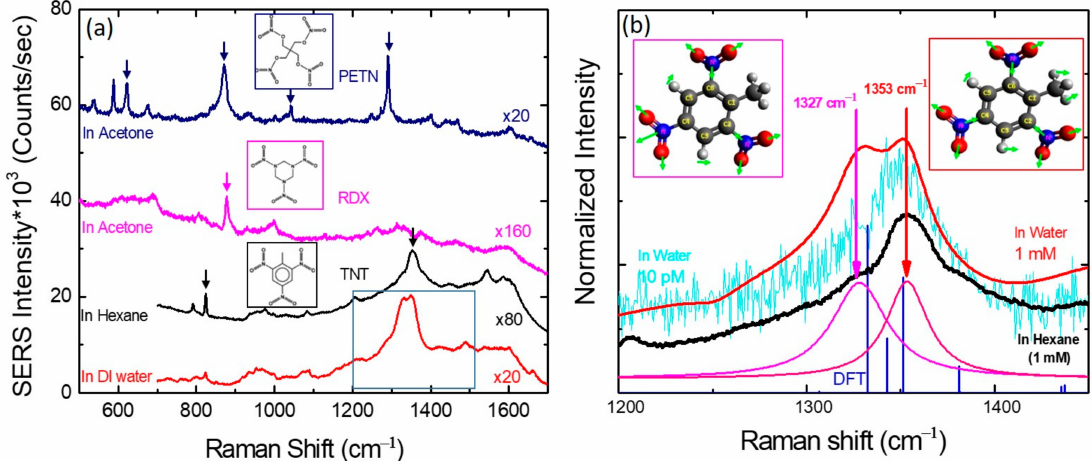
Figure 3. ( a ) SERS spectra from PETN, RDX, TNT/water, and TNT/hexane. The concentrations of all four samples are the same, 1 mM. The geometry of each molecule is given in the inset. ( b ) Symmetric NO 2 modes of TNT molecules in the SERS spectra compared with the DFT simulation results (blue). The vibrational directions (green arrows) of the atoms are shown in the